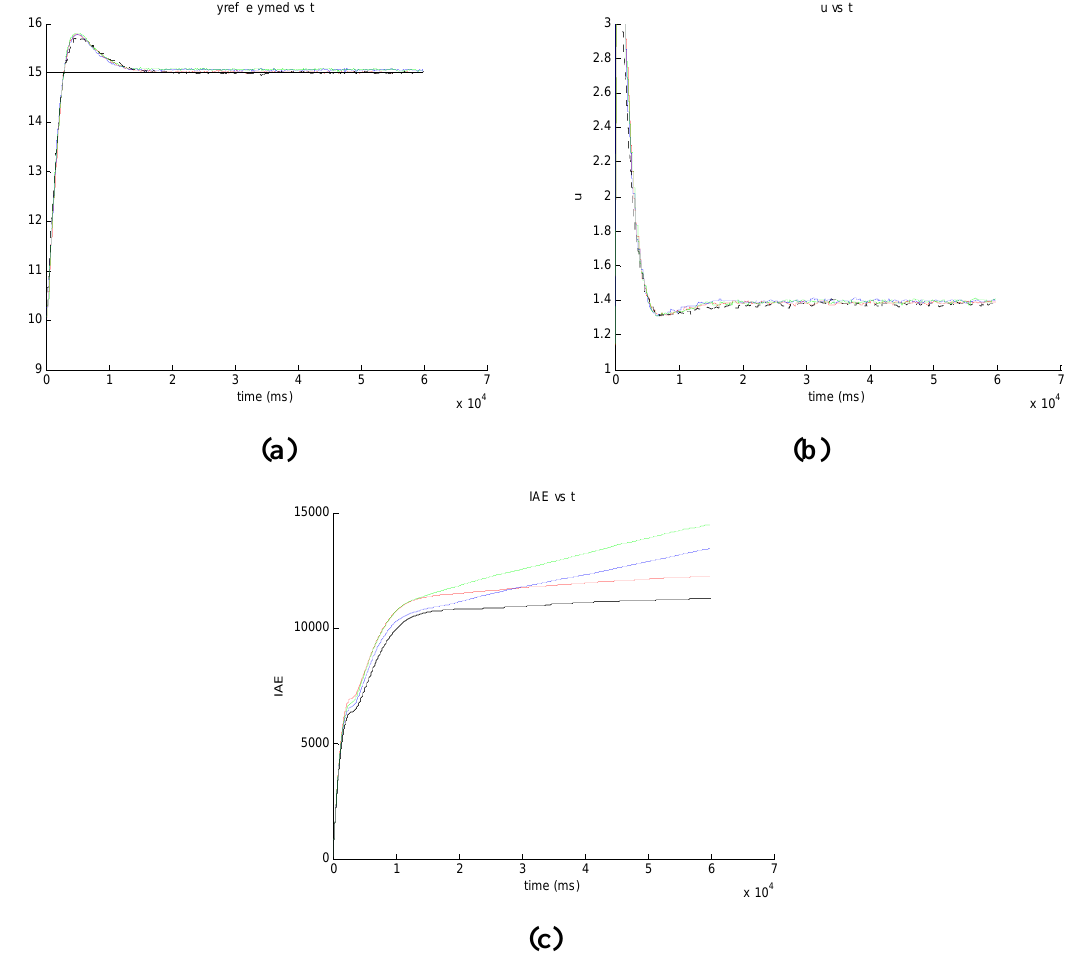
Figure 12. (a) System response, (b) manipulated variable, and (c) IAE of the time-based (black) and LP approaches with  = 0.1 (red), 0.2 (blue), and 0.3 (green). event